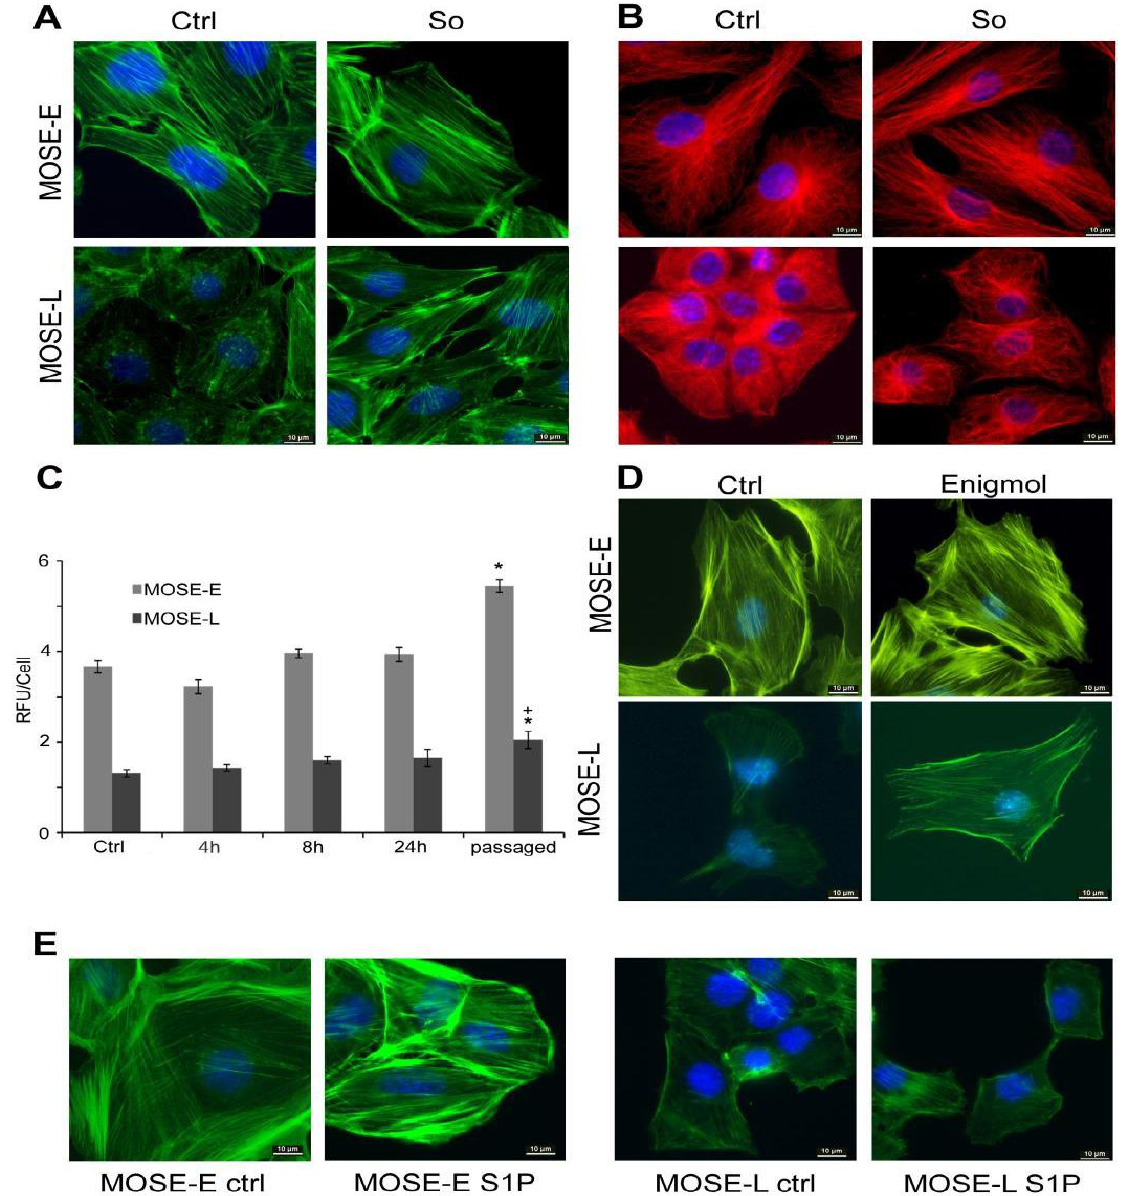
Figure 1. Sph treatment increases cytoskeleton organization. Mouse Ovarian Surface Epithelium (MOSE)-E and MOSE–L cells were grown in the absence (Ctrl) or presence of 1.5  µM sphingosine (So), fixed with paraformaldehyde and stained with AlexaFluor 488 - conjugated phalloidin to visualize filamentous actin ( A ) or with antibodies against ß- tubulin; ( B ) to visualize the microtubule network; ( C ) Quantitation of F-actin after 4–24 h treatment with 1.5 µM So, or continuous passaging. *significantly different from MOSE-E, p < 0.05, + different from untreated corresponding control, p < 0.05; ( D ) MOSE-E and L cells were treated with 1.0 µM enigmol for 3 passages and stained with AlexaFluor 488 -conjugated phalloidin; ( E ) MOSE-E and –L cells were treated with 500nM S1P for 8 h and stained with AlexaFluor 488 -conjugated phalloidin; (Original magnification